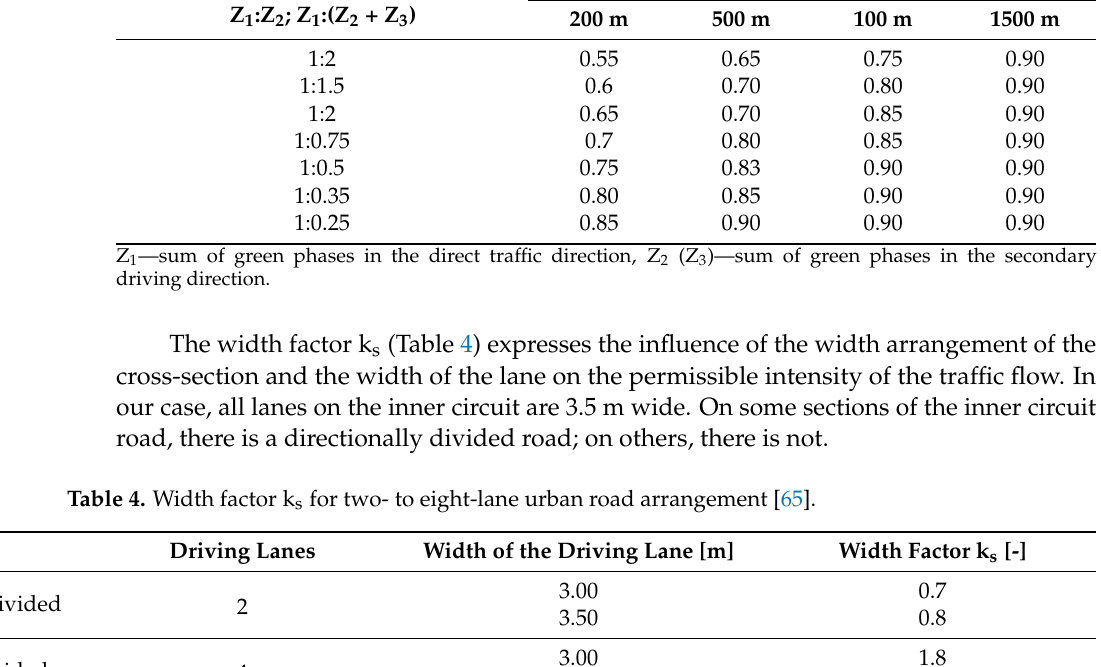
Table 3. Values of the influence factor of a light-controlled intersection k k [65]. Share of Green Phases in the Cycle